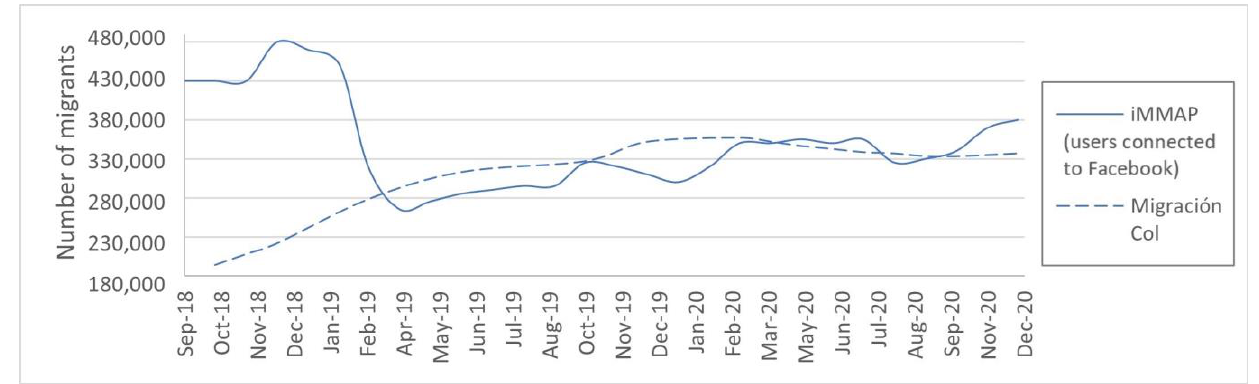
Figure 4. Comparison of Venezuelan migrants to Bogotá as reported by iMMAP vs. Migración Colombia.